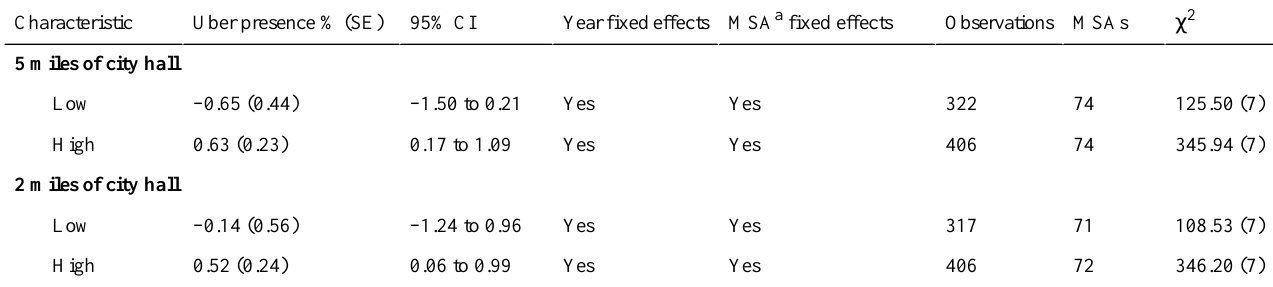
Table 3. Robustness check: marginal binge drinking effects using alternative density